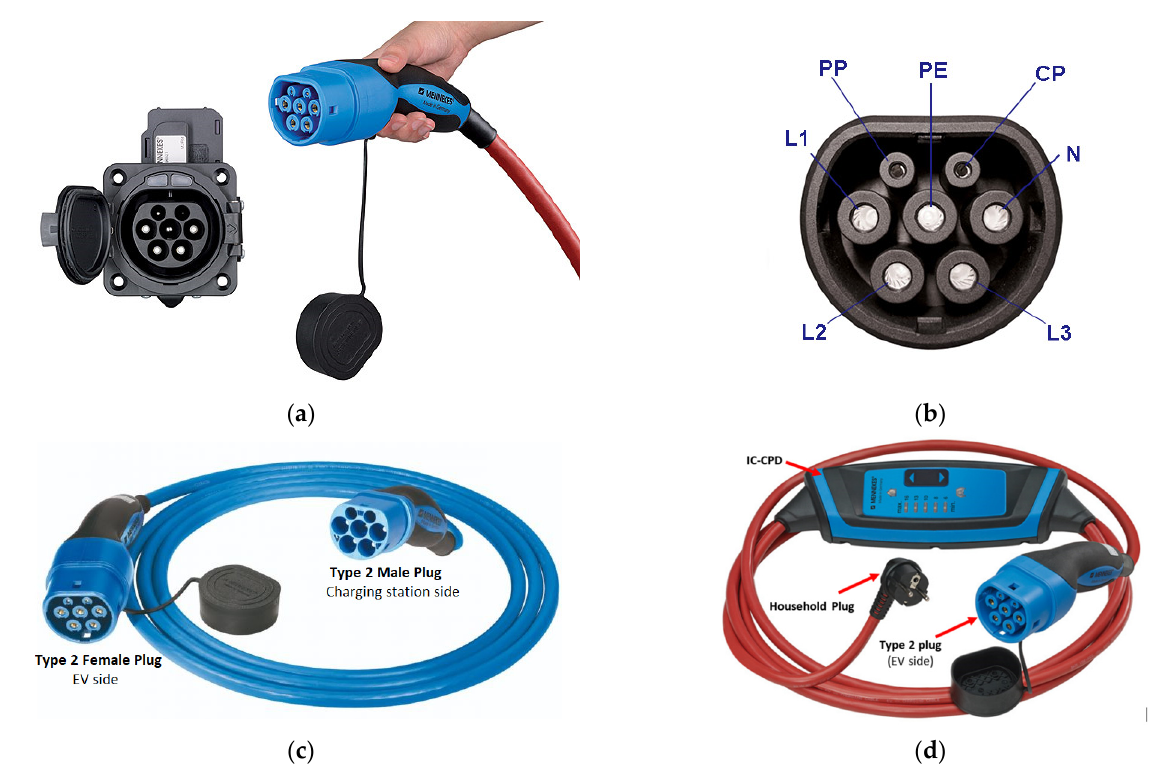
Figure 14. The type 2 EV coupler and associated devices: ( a ) Type 2 EV charging coupler: EV Inlet (Left) and EV Plug (Right); ( b ) Pinout of the Type 2 EV Plug; ( c ) Type 2-to-Type 2 Charging cable; ( d ) The Mennekes Type 2 portable EVSE.